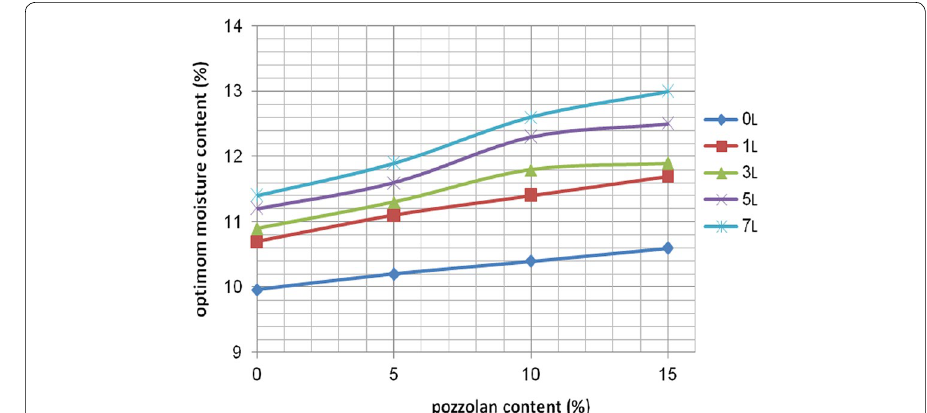
Fig. 3 The effects of pozzolan and lime on OMC and MDD